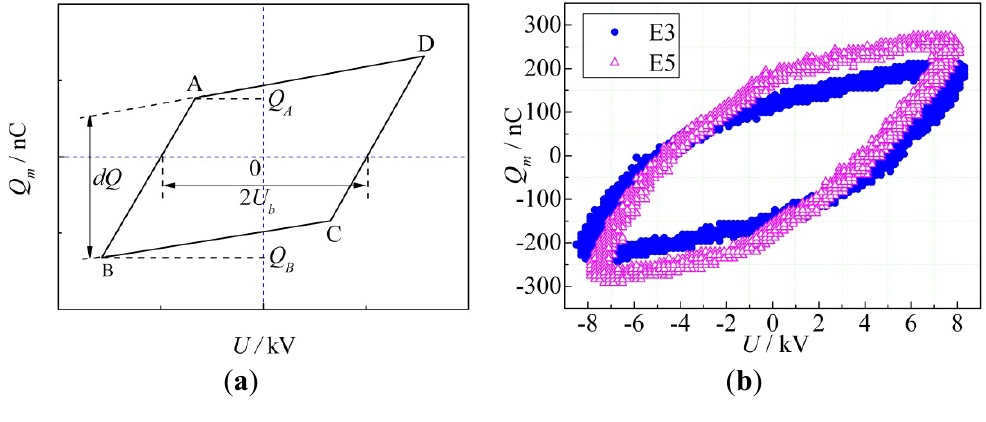
Figure 3. Lissajous figures: ( a ) Expected Lissajous figures; ( b ) Lissajous figures for the two different configurations at same voltage of 8.2 kV and same frequency of 27 kHz.